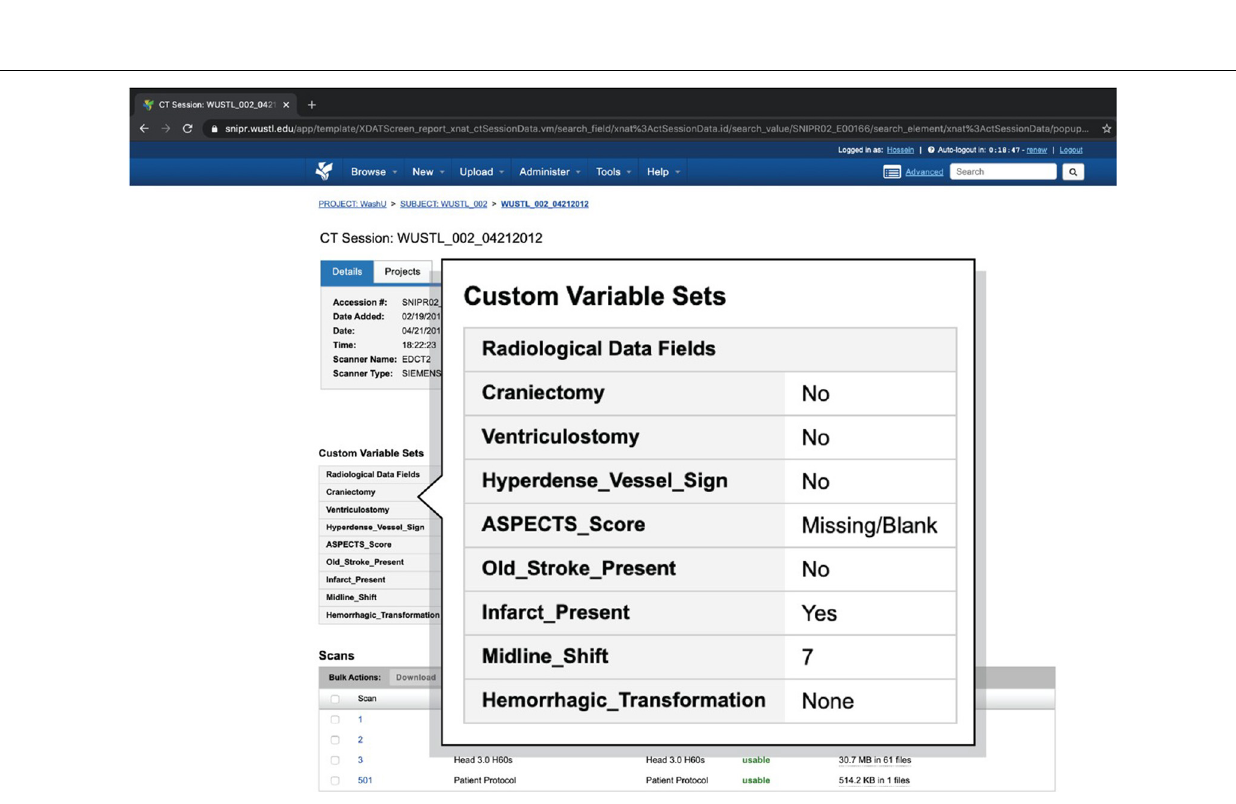
Frontiers in Neuroinformatics |